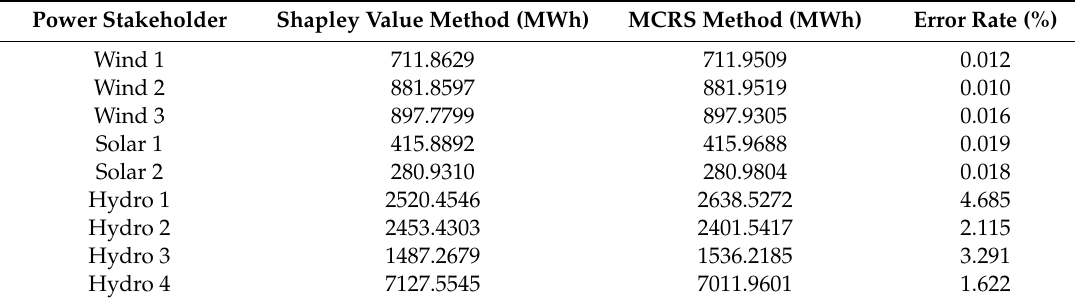
Table 6. Allocation results and error rates.